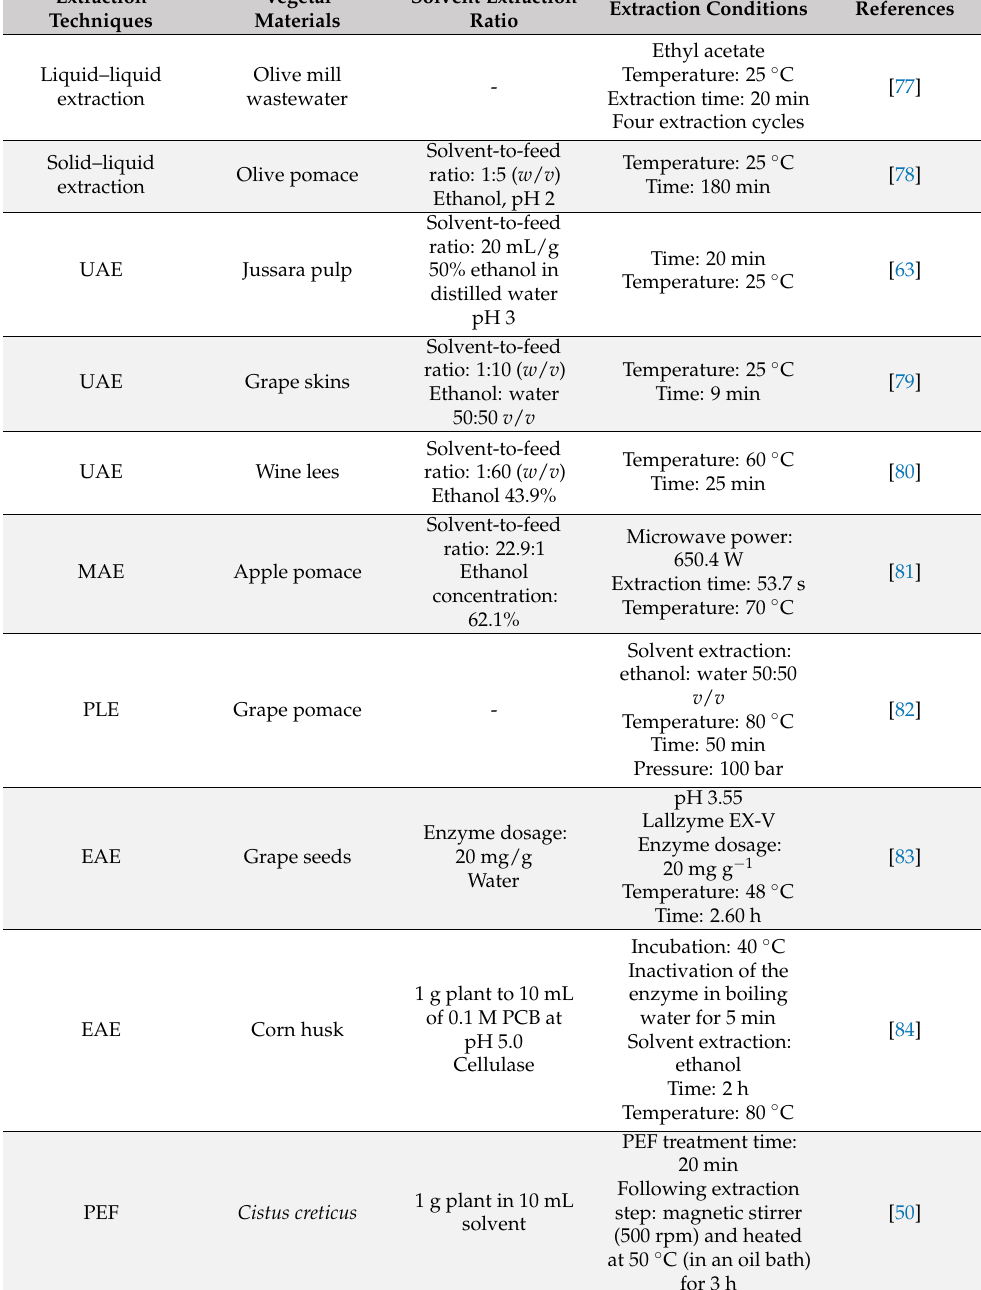
Table 1. Extraction of polyphenols through different modern extraction